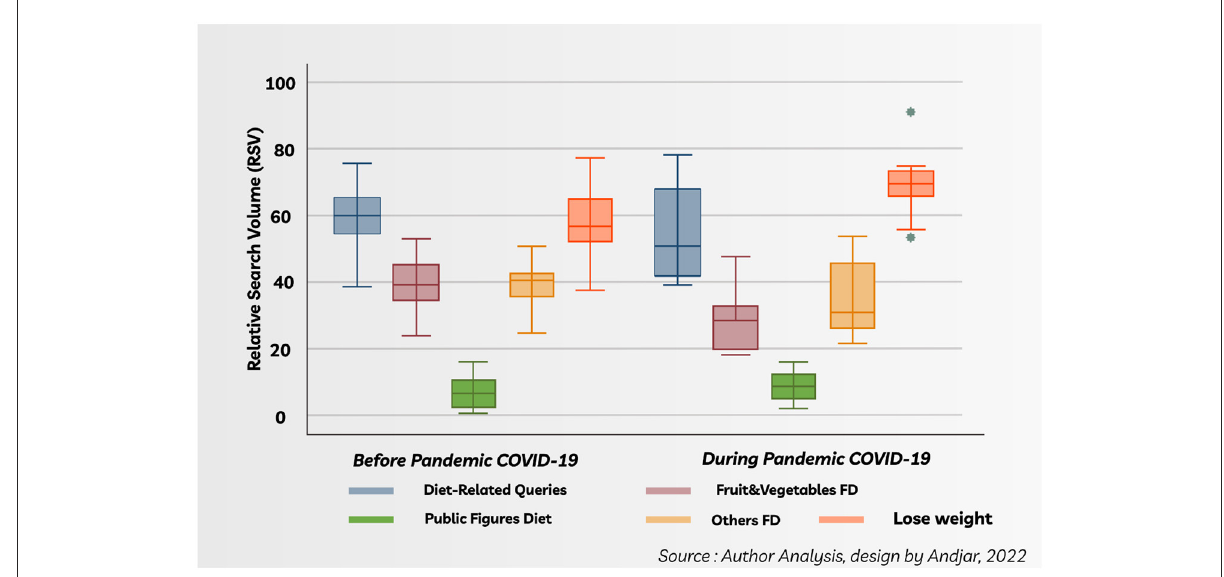
FIGURE2 Box plots of the RSV Topics before and during the COVID-19 pandemic.